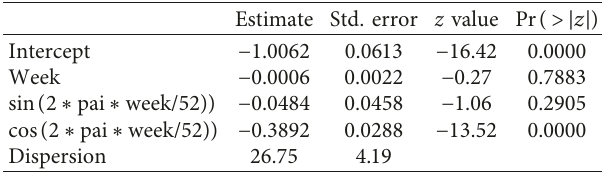
Table 10: Model summary.